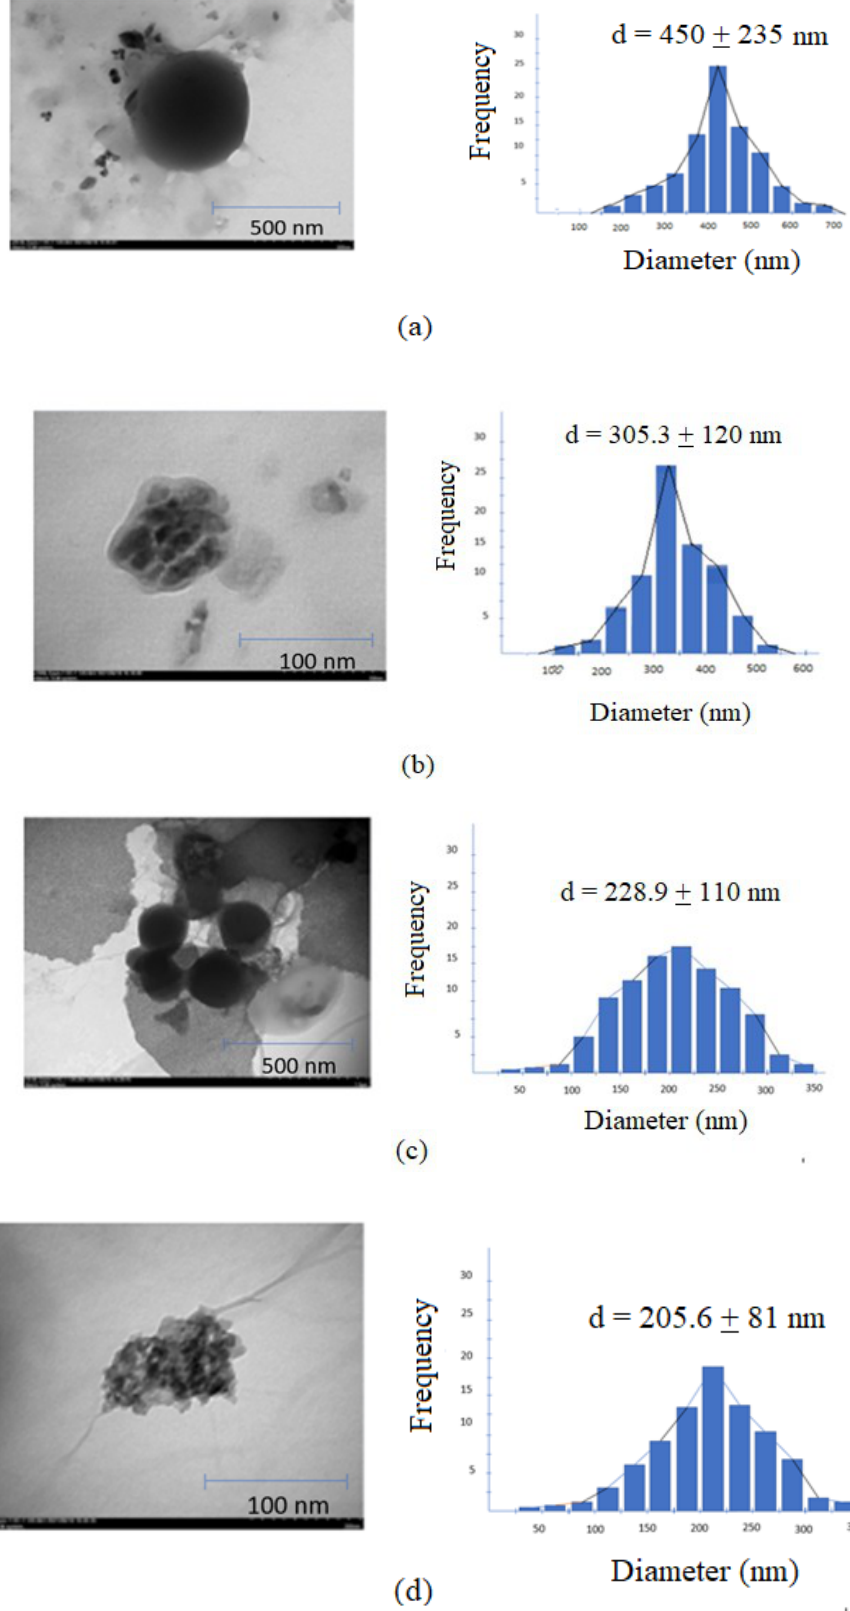
Figure 2. TEM images and size distribution analysis of ( a ) F1, ( b ) F2, ( c ) F3, ( d ) F4.